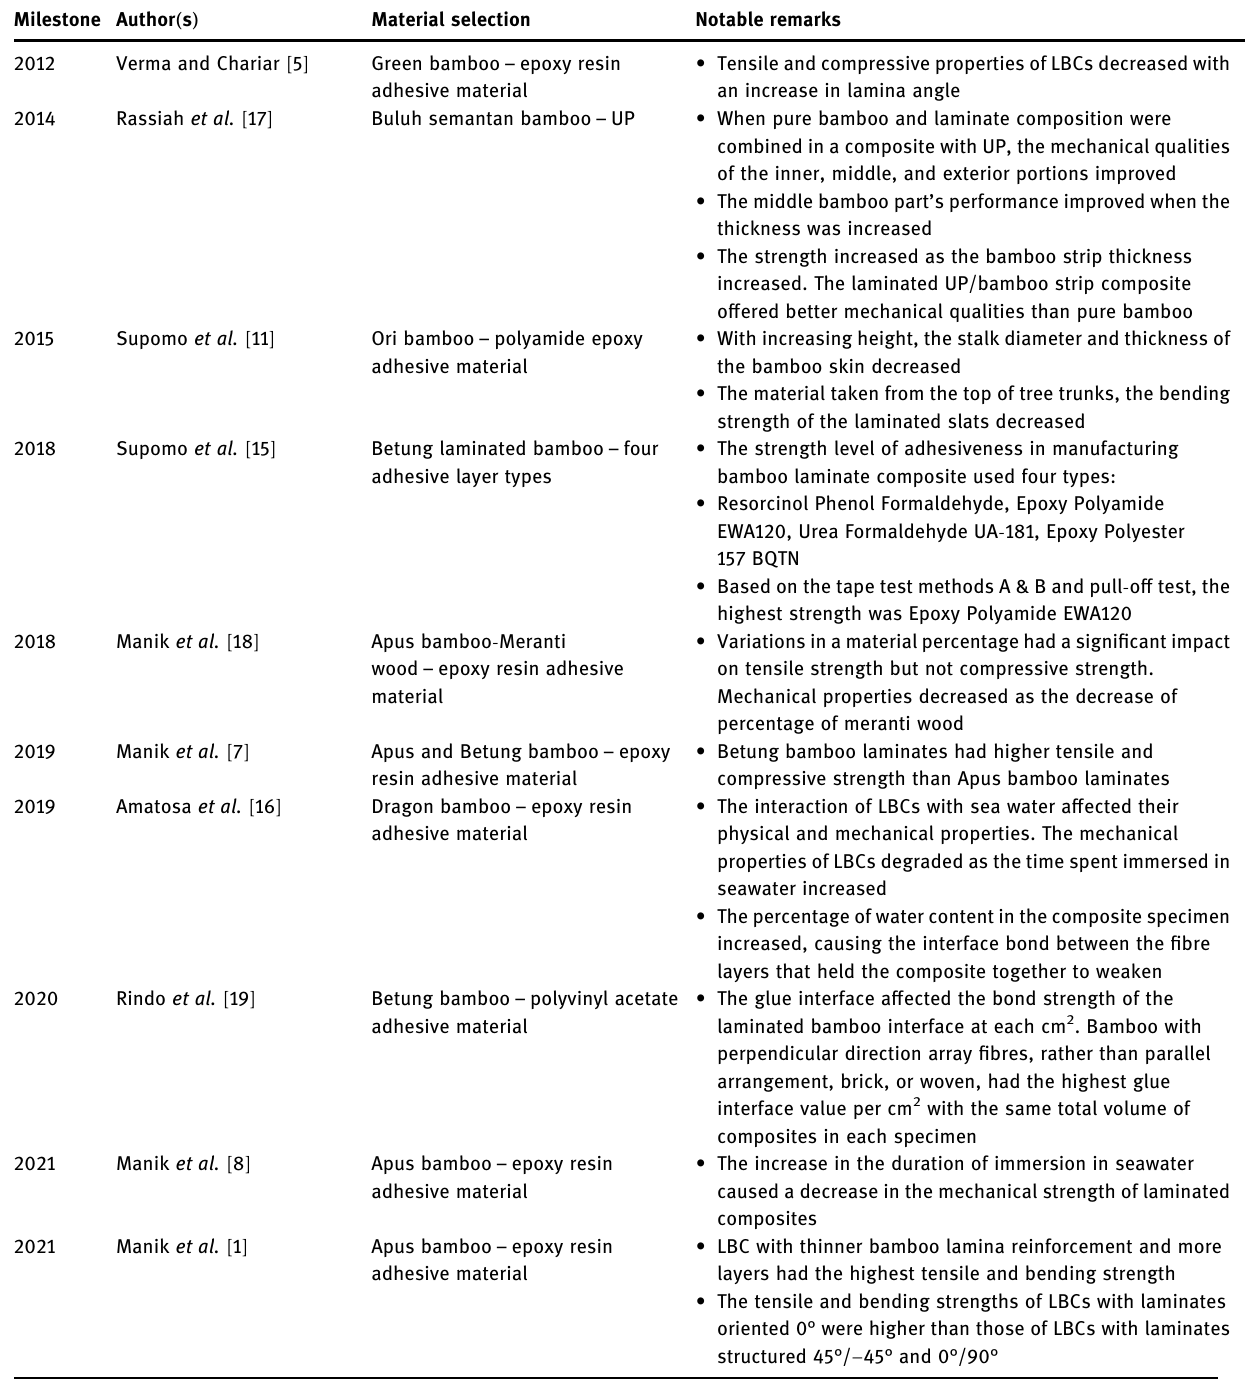
Table 1: Research landmark on the experimental testing development of LBCs Milestone Author ( s